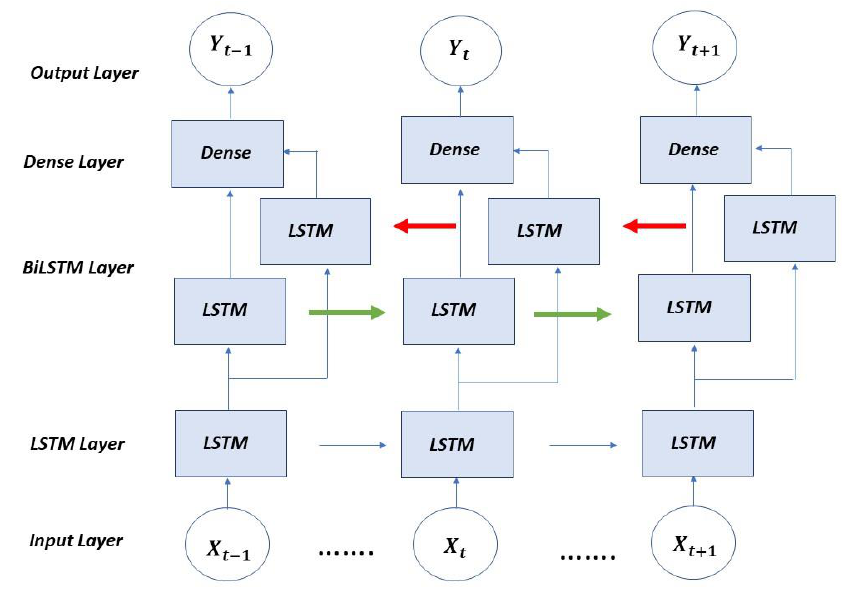
Figure 2. BiLSTM Figure 2. BiLSTM Model.